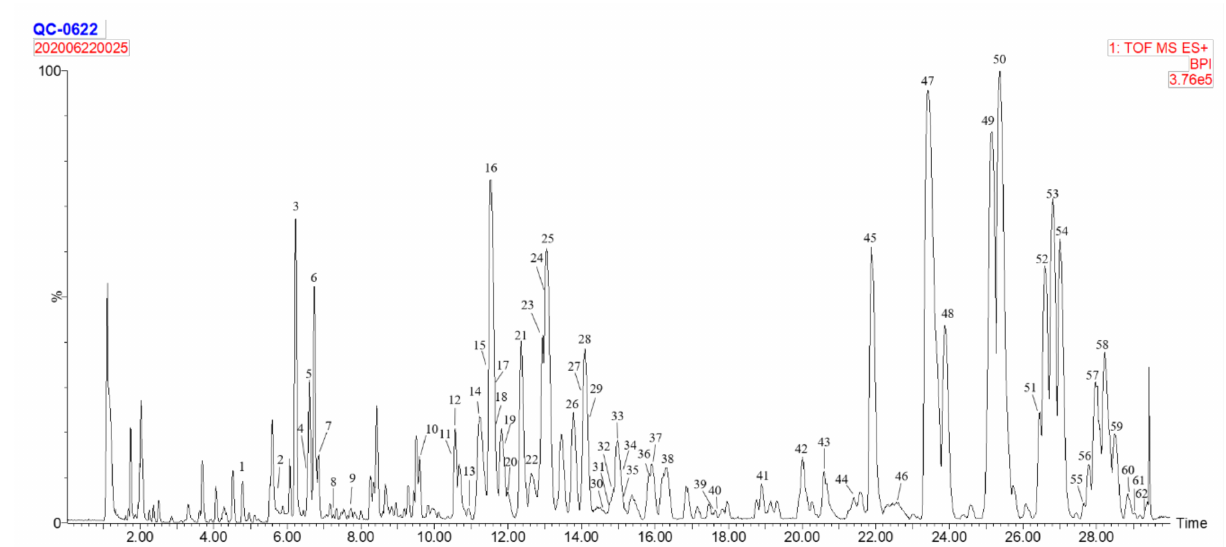
Figure 1. UPLC/Q-TOF-MS BPI chromatogram of lipid profiles in QC wheat